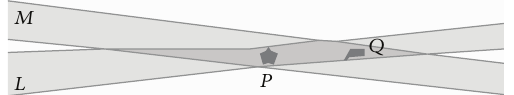
Figure 2: Two extended points do not uniquely determine the location of an incident extended